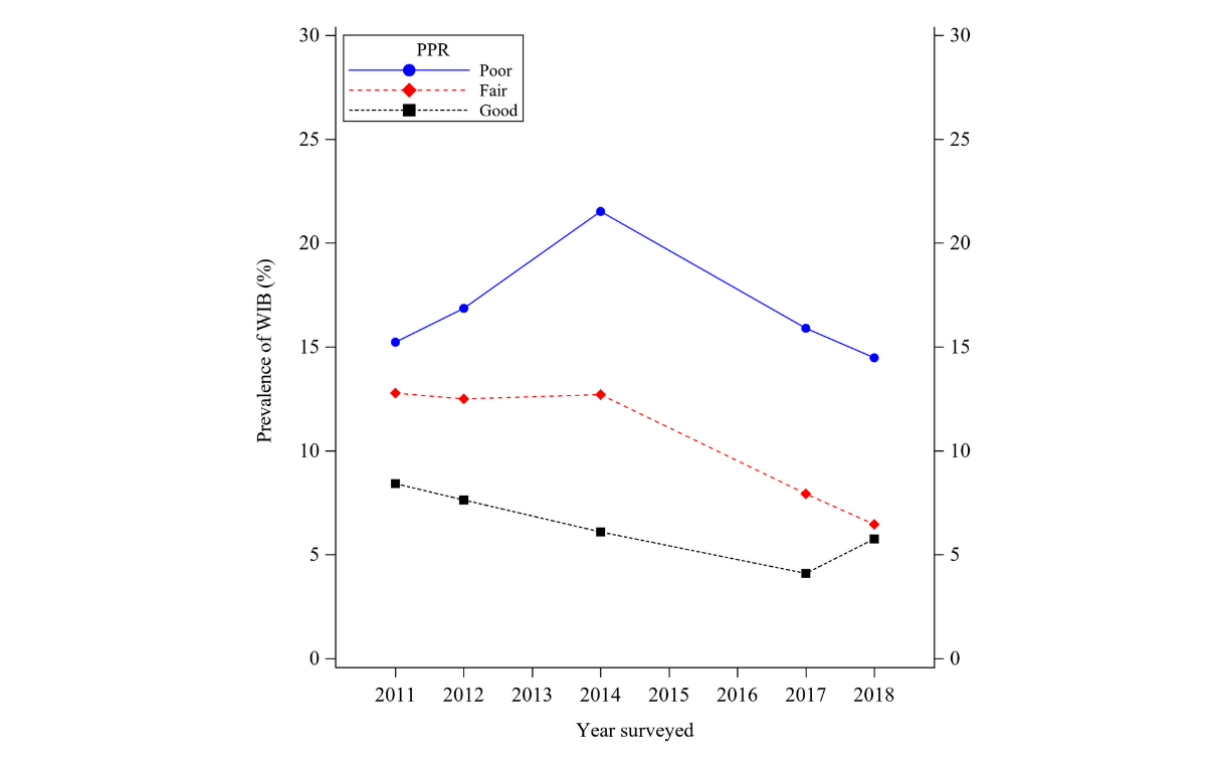
Figure 4. Unadjusted prevalence trends of withholding information behavior grouped by levels of patient-physician relationship and based on responses from the Health Information National Trends Survey between 2011 and 2018. WIB: withholding information